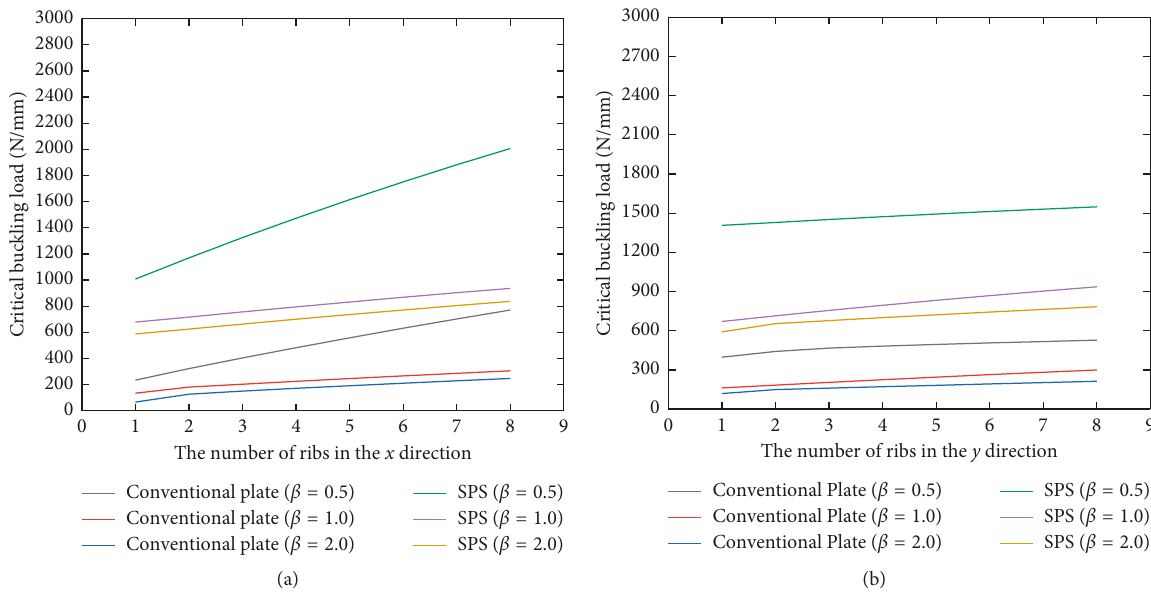
Figure 15: Critical buckling loads in the conventional plates and SPSs with different numbers of ribs: (a) x direction and (b) y